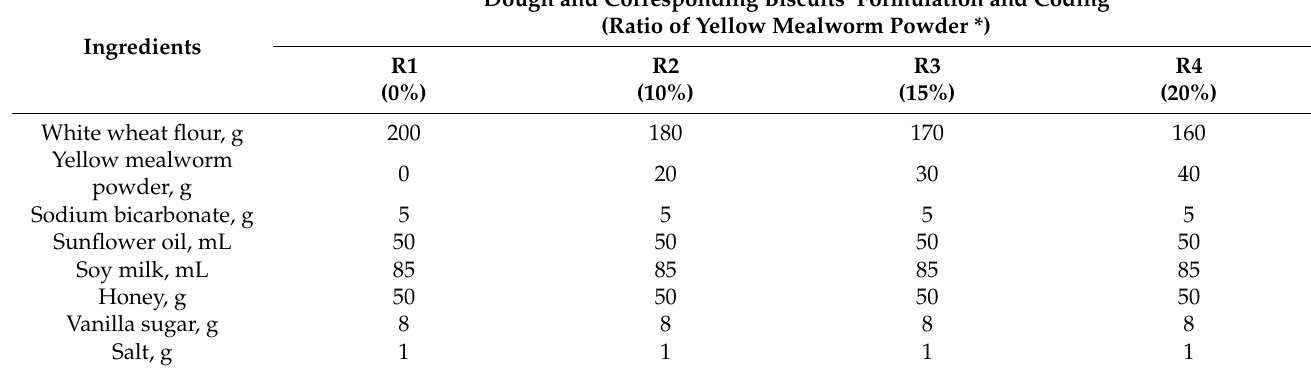
Table 1. Dough and corresponding biscuits’ formulation and